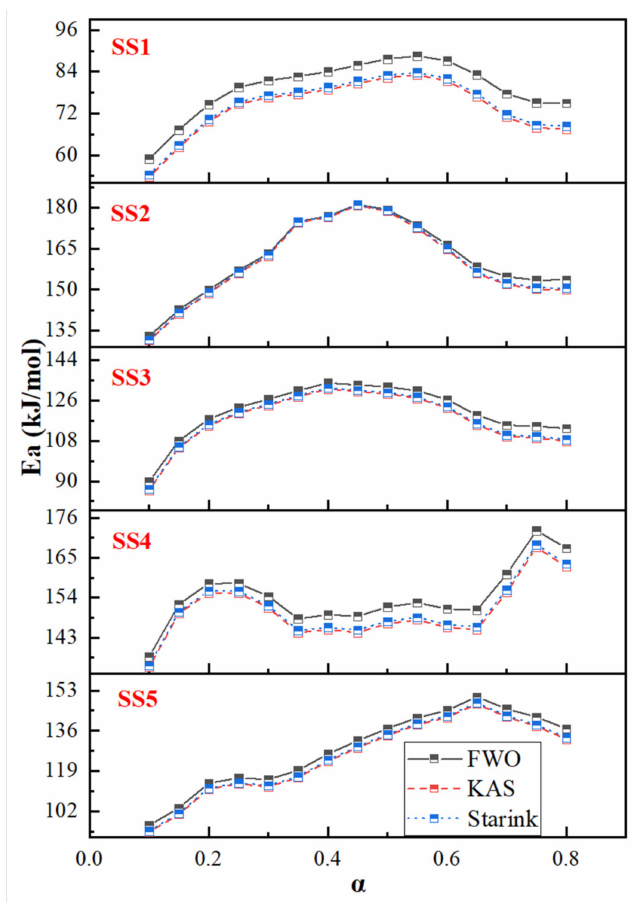
Figure 4. Apparent activation energy of SS at each